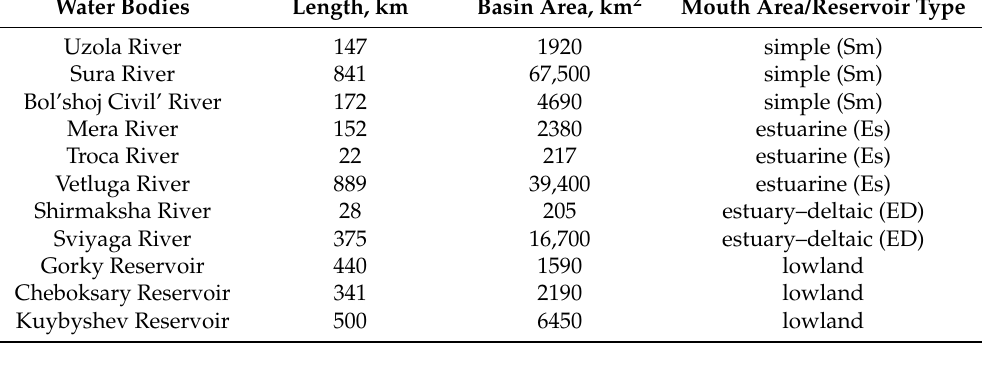
Table 1. Some morphometric parameters of the studied water bodies.